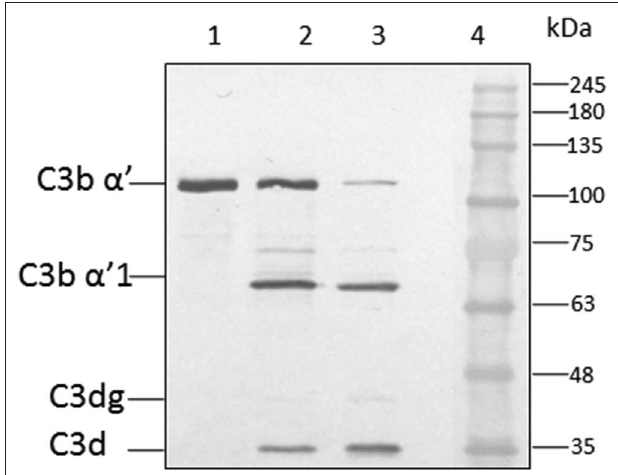
FIGURE 5 | Co-factor assay. Conidia of A. flavus were incubated with purified factor H in the presence or absence of 5,000 IU of heparin sulfate (HS). After extensive washing, both factor I and C3b were added. After incubation for 1h, the supernatant was separated and proteins resolved by SDS-PAGE, transferred to a NC membrane and probed with anti-C3 antibody. The positions of the C3b α ’ and it’s cleaved forms are indicated. Lanes 1, purified C3b control (500 ng); 2, supernatant of C3b and FI after incubation with 5,000 UI of Heparin sulfate and 5 µ g CFH; 3, supernatant of C3b and FI after incubation with 5 µ g CFH on conidia; 4, protein marker (PM).